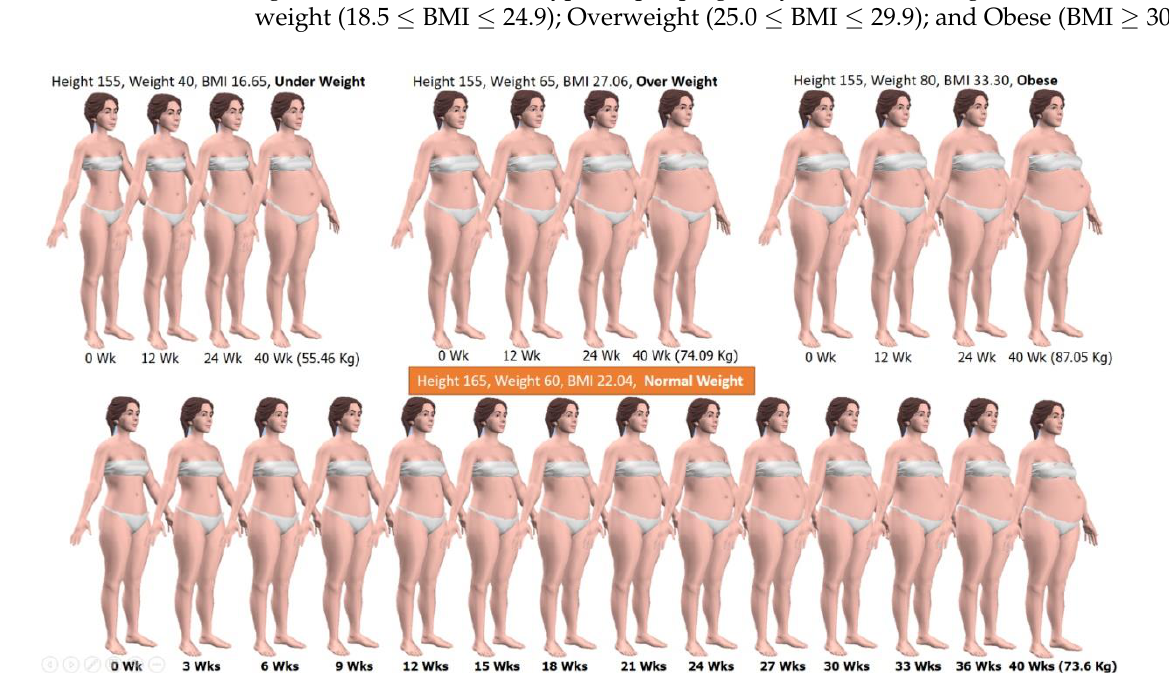
Figure 5. The simulated 3D models before pregnancy and during pregnancy 12, 24, and 40 weeks with four types of pre-pregnancy BMI: underweight, normal weight, overweight and obese.